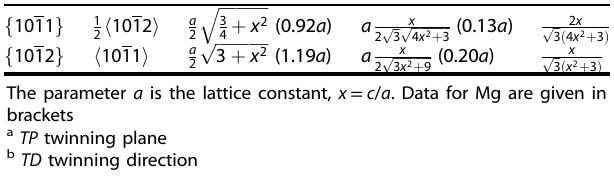
Table 1. Crystallographic elements and parameters of twin systems in